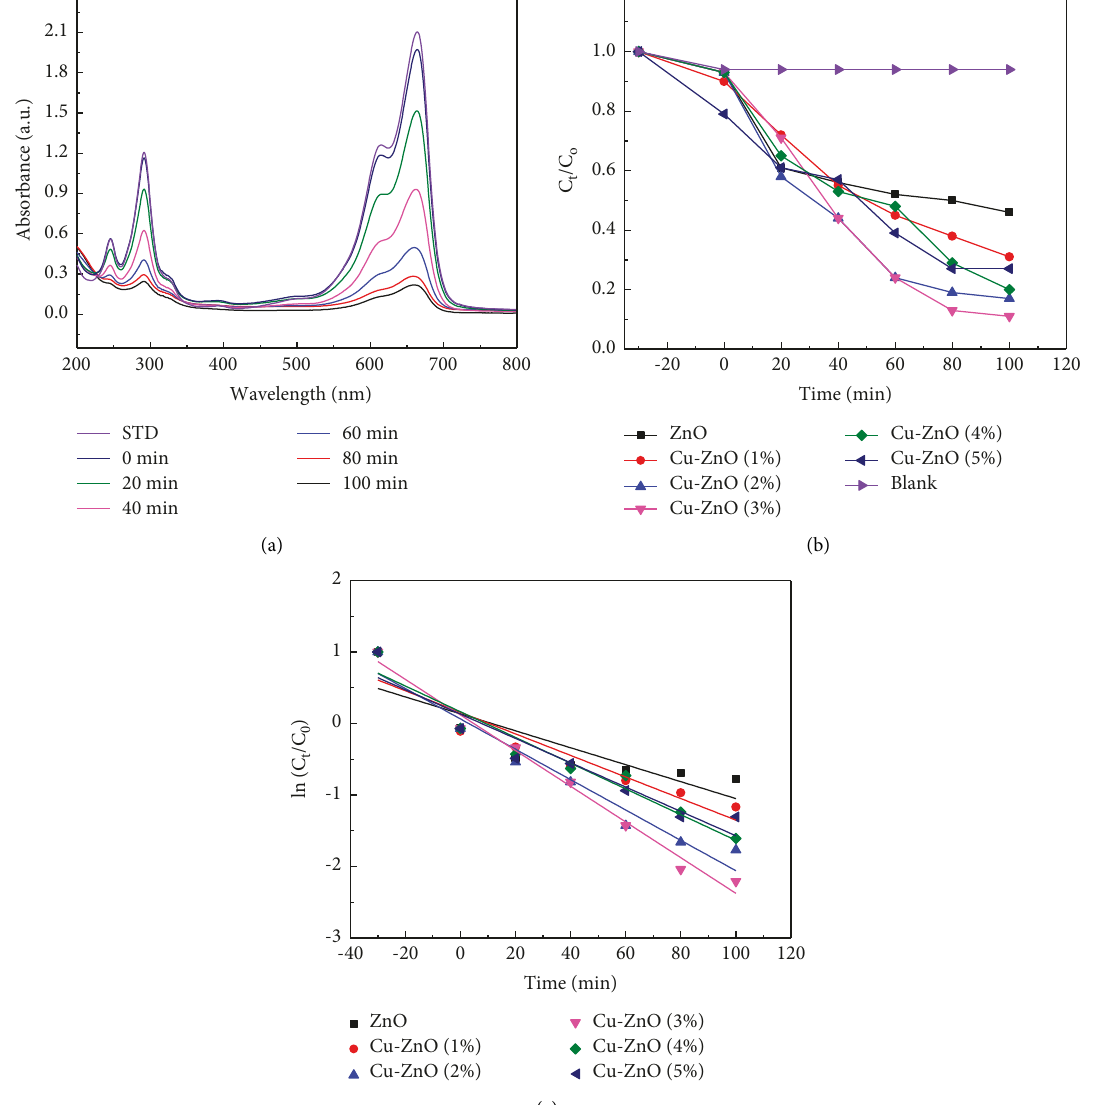
t / C 0 plots and (c) the first-order kinetic plot for ZnO, Cu-ZnO (1%), Cu-